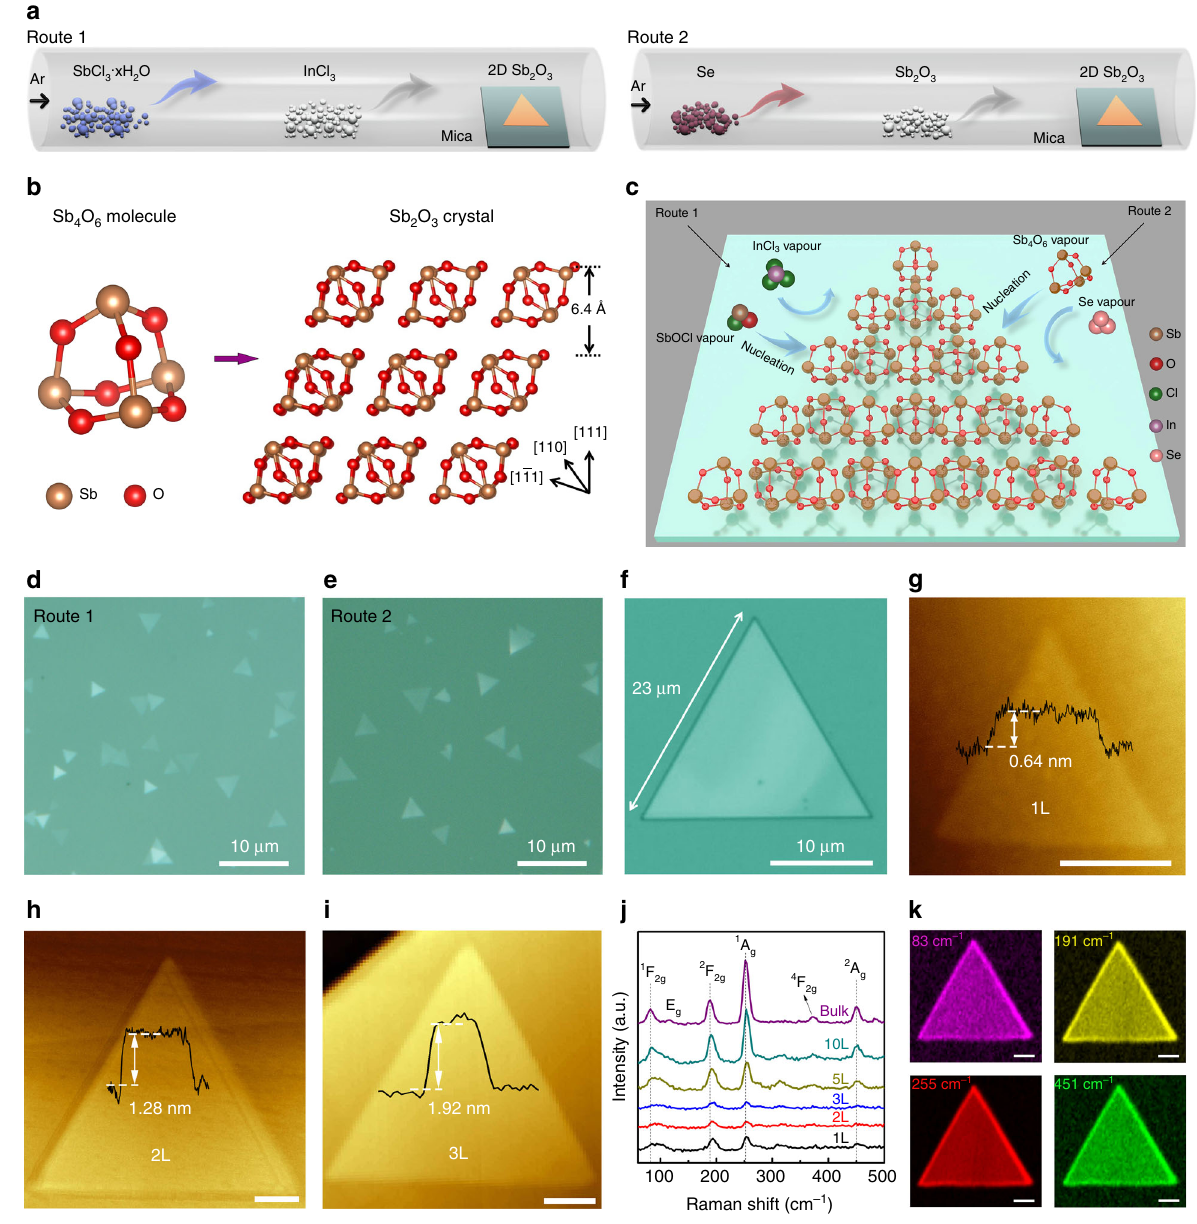
Fig. 1 PAVD growth of 2D Sb 2 O 3 molecular crystals. a Schematic diagram of passivator-assisted vapor deposition (PAVD) growth of Sb 2 O 3 fl akes in a tube furnace. In Route 1, precursor SbCl 3 ∙ x H 2 O, undergo a chemical reaction and grow to Sb 2 O 3 fl akes on mica with the assistance of passivator InCl 3 . In Route 2, precursor Sb 2 O 3 become gaseous, and grow to Sb 2 O 3 fl akes assisted by passivator Se. b Ball-and-stick structural models of spherical Sb 4 O 6 molecule and Sb 2 O 3 molecular crystal. c Schematic of PAVD growth of 2D Sb 2 O 3 molecular crystals on mica. The reaction involves: (1) nucleation of Sb 2 O 3 clusters from decomposition of SbOCl vapor (Route 1) and adsorption of Sb 4 O 6 vapor (Route 2); (2) adsorption of passivators; (3) horizontal growth of Sb 2 O 3 fl akes along the mica surface. d , e Optical images of ultrathin triangular Sb fl akes deposited on mica by Route 1 and Route 2. f Optical image of a 2 O 3 triangular Sb 2 O 3 fl ake as large as ∼ 23 µ m. g − i Representative AFM images of monolayer (1L), bilayer (2L), and trilayer (3L) Sb 2 O 3 fl akes. Scale bars, 200 nm. j Layer-dependent Raman spectra of Sb 2 O 3 fl akes from 1L to bulk. k Spatially resolved Raman mapping images of an Sb 2 O 3 fl ake at four peak frequencies 83, 191, 255, and 451 cm − 1 . Color scales, black to colorized, low to high Raman intensity. Scale bars, 2 μ intermolecular mode and the others are intramolecular ones. The – O – Sb stretch mode while 2 F 1 A 2 A Sb 2 O 3 . Such a blueshift could be a result of the decreased long- g mode is from Sb 2g and g are range Coulombic intramolecular interactions in thinner fl akes 25 . classi fi ed into Sb – O – Sb bend modes. The spatially resolved The relation between frequency and number of layers for 2 F 2g Raman mapping images at four peak frequencies (83, 191, 255, peak and 1 A g peak is plotted in Supplementary Fig. 5a, showing a and 451 cm – 1 ) reveal the uniform triangular domain of the Sb 2 O 3 monotonic decrease trend of frequency with increasing layer crystal (Fig. 1k). number. The molecular vibrations of four Raman modes Figure 2a, b illustrates the top-view ball-and-stick models of are illustrated in Supplementary Fig. 5b. The 1 F 2g mode is an monolayer and trilayer Sb 2 O 3 fl akes with (111) plane, which is the